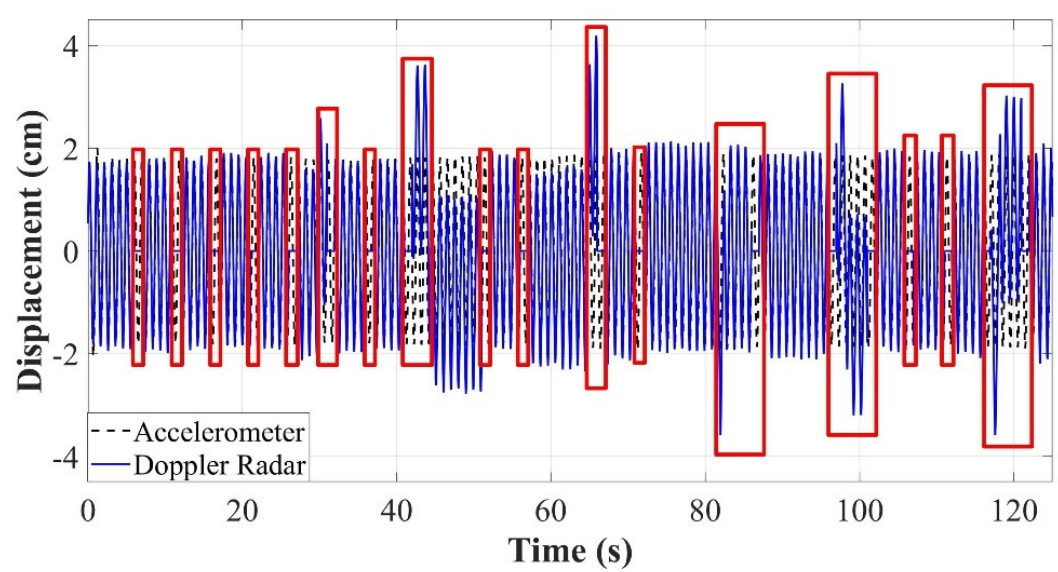
Figure 6. Displacement corrected by a time-domain-based approach. The distortions are high- lighted.